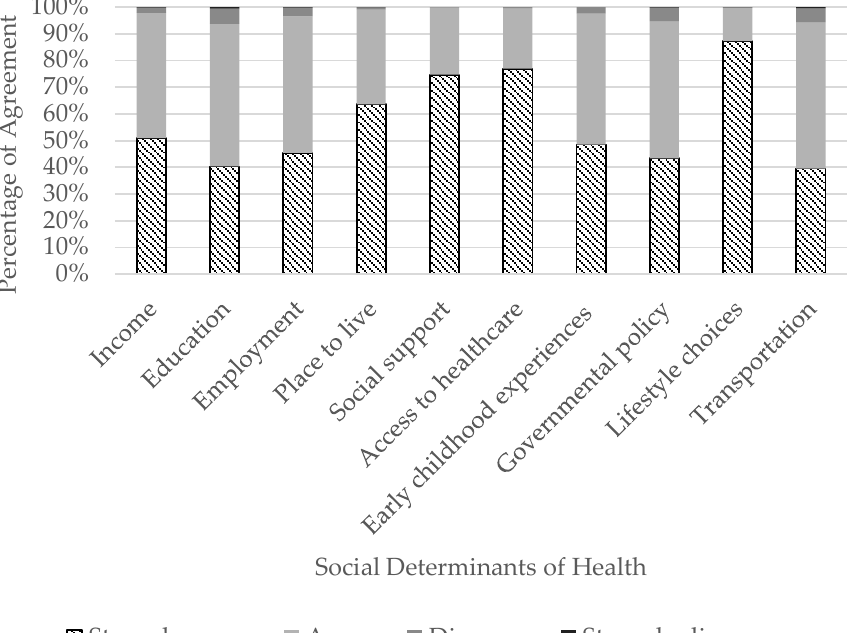
Figure 1. Athletic trainers’ perceptions of the influence social determinants of health have on people’s health.